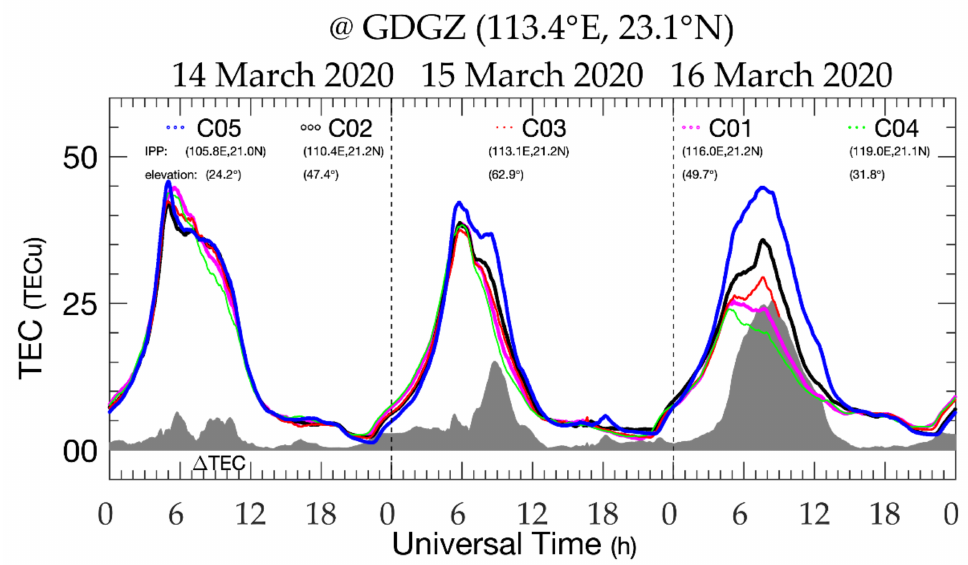
Figure 4. Similar to Figure 1, but for the GEO TEC and ∆ TEC during 14–16 March (DOY